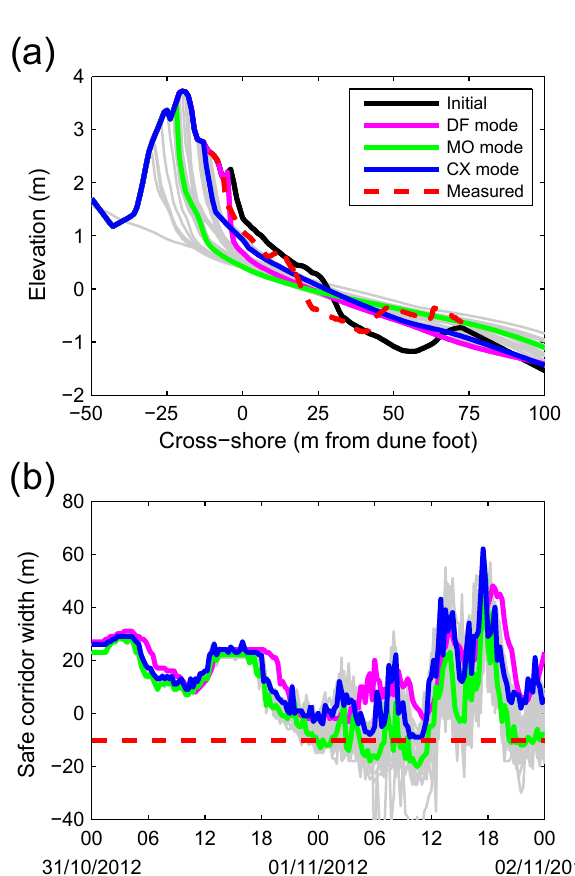
Figure 8. Forecast results at profile line classe02 at the Lido di Classe validation site: (a) profile change forecasts, (b) safe corri- dor width forecasts. Grey lines correspond to the 32 different model runs undertaken during the calibration process.